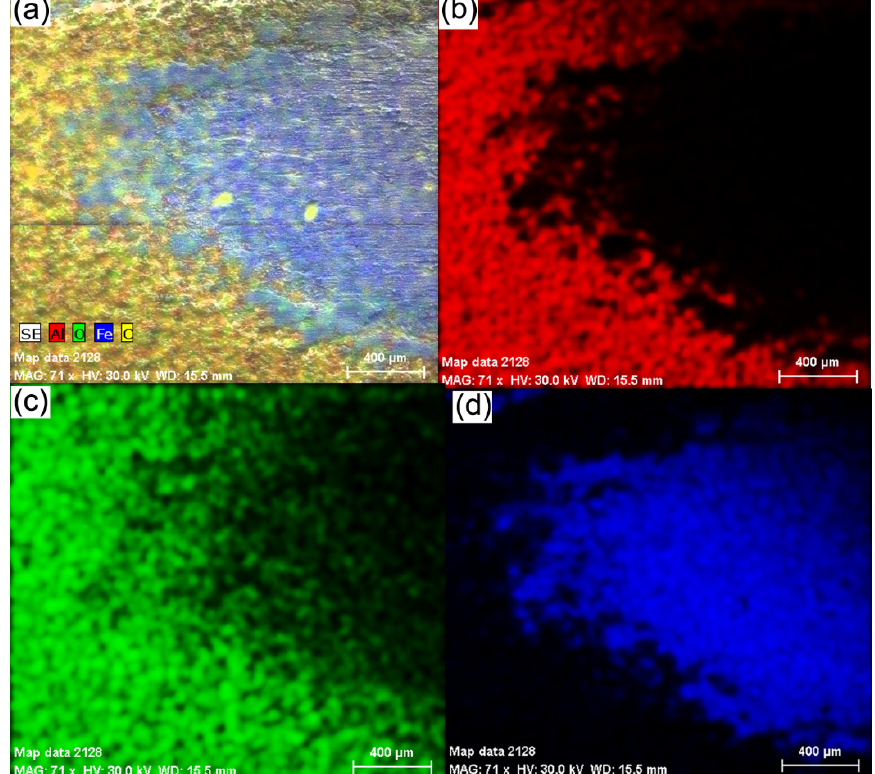
Figure 9. SEM images of the worn zone during the test: ( a ) wear trace; ( b ) detail of the wear end area; ( c ) wear edge.